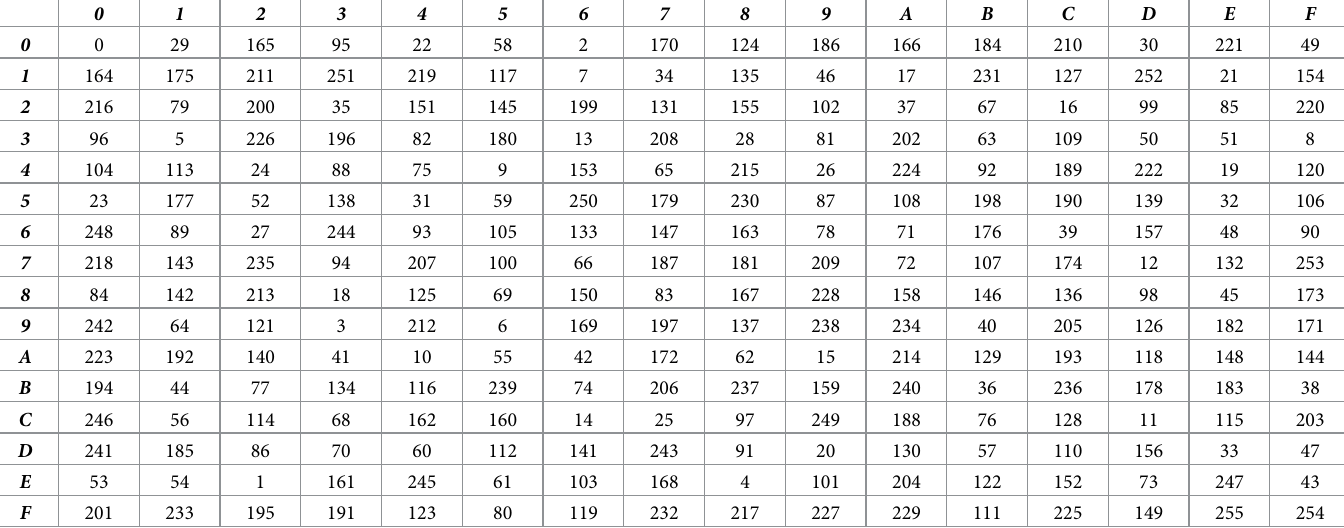
Table 5. Proposed S-box (S4) in 16 × 16 matrix form—Generated with T 4